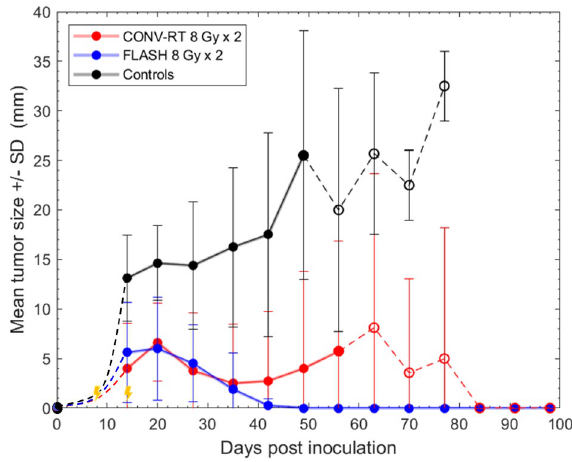
Figure 3. Tumor size in animals with subcutaneous tumors. Mean tumor size ± SEM in animals with subcutaneous glioblastoma irradiated with FLASH 8 Gy × 2 or CONV-RT 8 Gy × 2, as well as non-irradiated control animals (n = 8 per group). At day 0, tumor cells were inoculated, and tumor size was set to 0 mm. During the first measurements, ≤ 7 days after inoculations, tumors were small and difficult to measure exactly, and estimated size is indicated by dotted lines (- - -). From day 14 after tumor cell inoculations, tumors were distinctly measurable, and size is indicated by dots. Lines connect the different measurements as long as all animals are represented in the individual groups, but are replaced with dotted lines (- - - -) when at least one of the animals have been euthanized due to tumor growth > 30 mm. This means that the measurement points only represent tumor size of animals still alive. Days of irradiations are marked with yellow